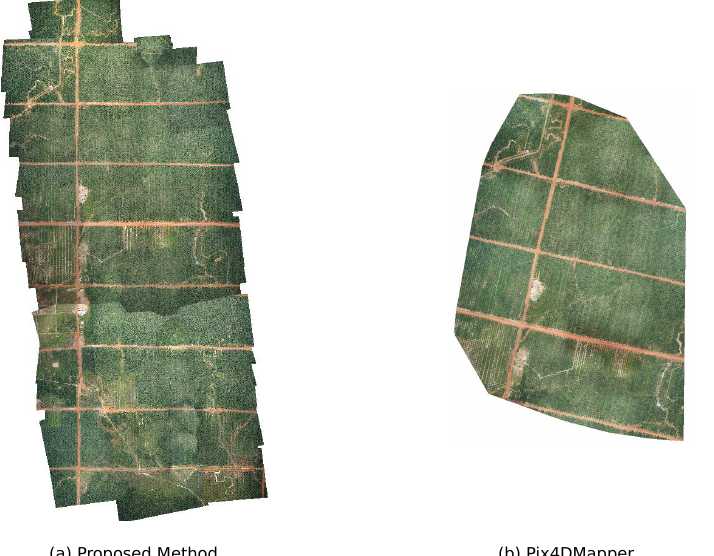
Figure 6. Images with low overlapping rate (30%) are collected for stitching comparision experiments between the proposed method ( a ) and Pix4DMapper ( b